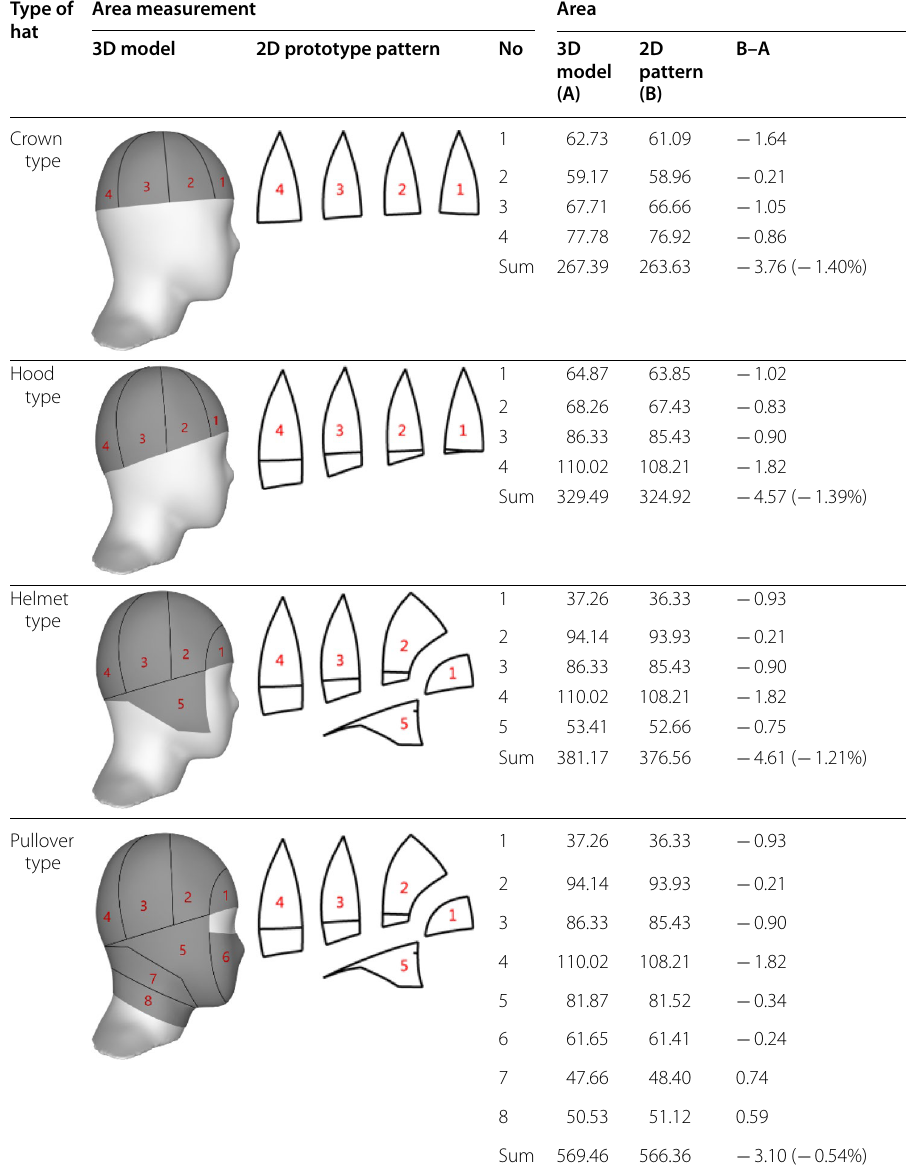
Table 13 Verification of the developed prototype hat patterns (unit: mm 2 , %) Type of